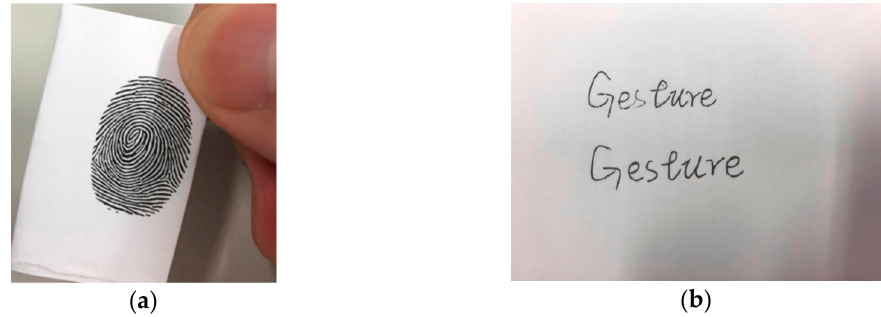
Figure 1. Different types of cheating on static physiological characteristics. ( a ) Is a fingerprint copy and ( b ) is imitation of handwriting.